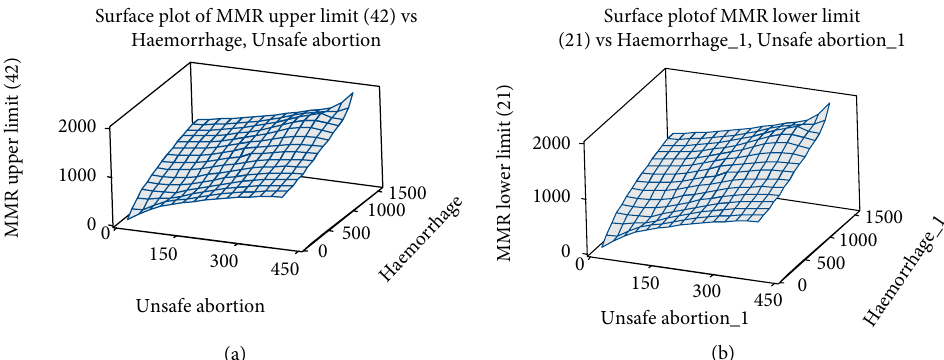
Figure 9: (a) Three-dimension surface plot of MMR values vs. haemorrhage and unsafe abortion for target MMR 42. (b) Three-dimension surface plot of MMR values vs. haemorrhage and unsafe abortion for target MMR